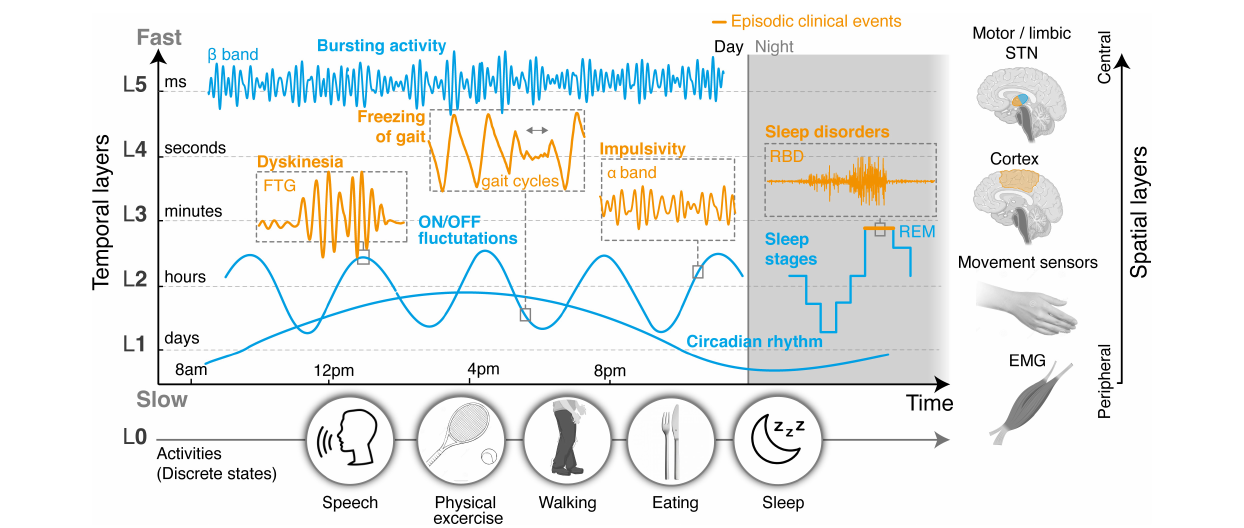
FIGURE 1 | Layered organization of control sources, segregated in time and space. Clinical and neural manifestations, both episodic and non-episodic, evolve according to distinct time-constants that can be categorized into a range of temporal layers, from milliseconds (fastest layer, L5) to days (slowest layer, L1). An additional layer (L0) could capture changes in manifestations related to discrete states, such as daily activities, and operate in parallel to the others. In this proposed modular structure, layers may not be independent, since manifestations at different timescales can affect each other. Thus cross-layer interactions must also be accounted for. On top of differences in their temporal properties, neural processes may also be spatially segregated, and picked up from different locations in the brain or the periphery. Hence temporal and spatial layers may be combined to simplify, cluster, or distribute how symptoms are optimally monitored, detected, and addressed. Overall, this representation establishes a conceptual framework by which the clinical state of a patient can be described as the modular superposition of parallel, yet inter-dependent manifestations segregated in time and space. Closed-loop control approaches may mirror this layered organization in the design of multi-objective therapies that can concurrently address multiple symptoms, while suitably dealing with dependencies. L, temporal layer; STN, subthalamic nucleus; ON/OFF, with/without medication; FTG, finely tuned gamma